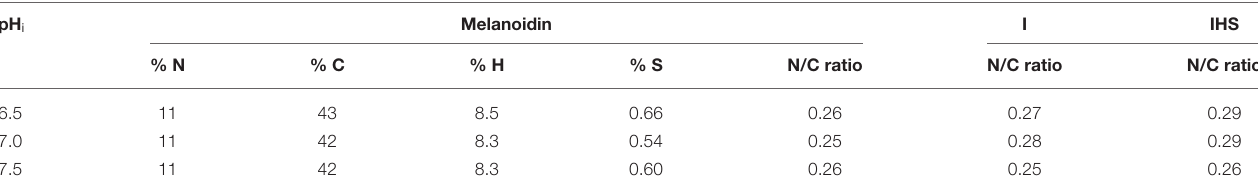
TABLE 2 | Elemental composition of the melanoidin fractions from the three DL prepared at different pH i values * . pH